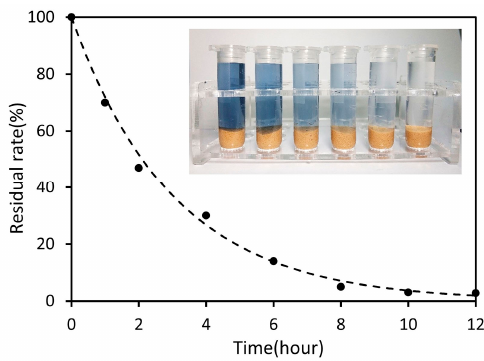
Figure A5. TEM micrographs of the Ag nanoprisms after the detection of dissolved oxygen (50 µM, 1.6 mg/L), the shape of Ag nanoprisms changed owing to the etching.